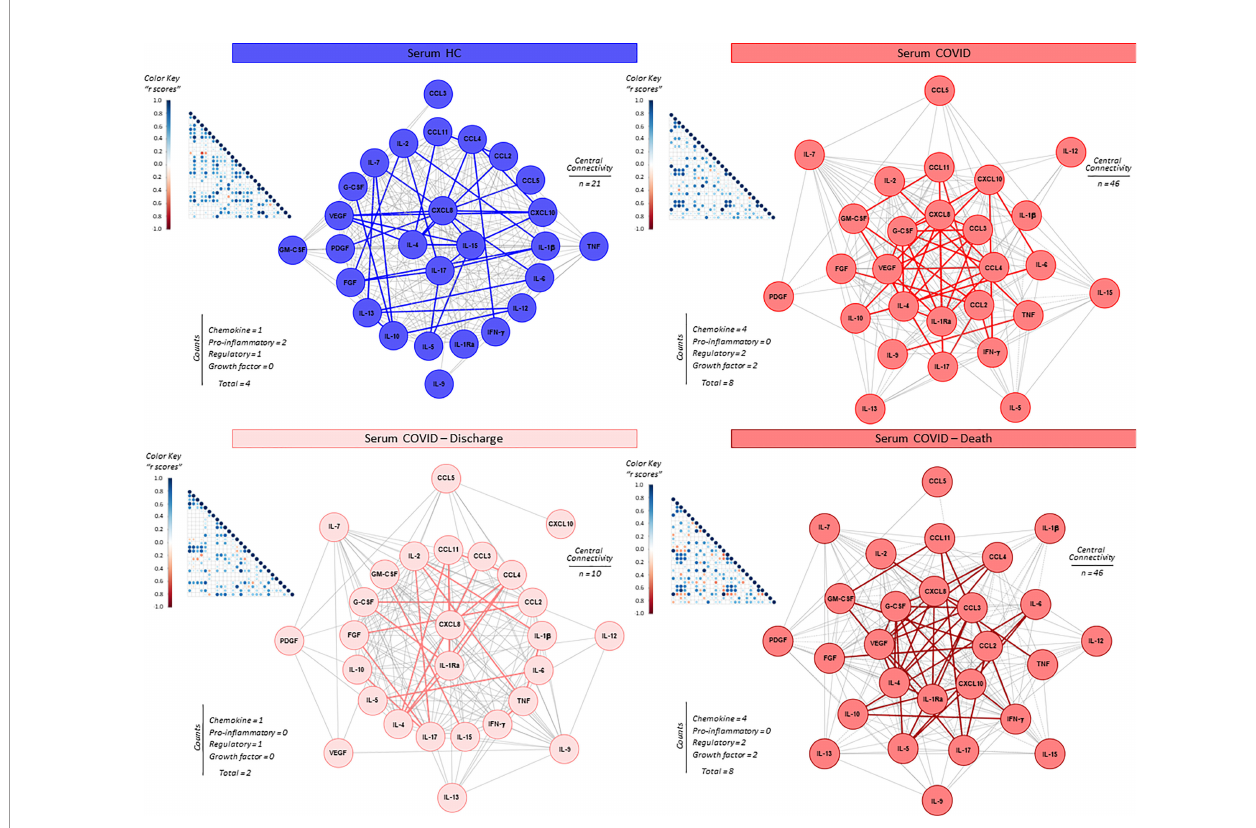
FIGURE 3 | Integrative correlation matrices and networks analysis of serum soluble immune mediators in critically ill COVID-19 patients at ICU admission. Comprehensive correlation matrices were assembled based on the Pearson and Spearman “ r ” scores between chemokines, pro-in fl ammatory cytokines, regulatory cytokines and growth factors measured in serum samples from critically ill COVID-19 patients – “ COVID ” ( ● , n = 183) at ICU admission (D0=baseline), further classi fi ed according to disease outcome: referred as “ Discharge ” ( ● , n = 97) or “ Death ” ( ● , n = 86) and pre-pandemic healthy controls – “ HC ” ( ● , n = 135). The soluble mediators were measured by high-throughput microbeads array as described in Material and Methods section. Panoramic correlation matrices are shown as triangle templates with each square intersection representing the “ r ” correlation score between pairs of attributes. The “ r ” scores of signi fi cant correlations (p < 0.05) are represented by circles of proportional sizes, scaled from − 1 to +1 with gradient for negative (red dots) and positive (bule dots) according to the color key provided in the fi gure. The white squares represent non-signi fi cant correlations. Networks were built using a layout based on eccentricity, considering all signi fi cant correlations. The nodes represent the chemokines (CXCL8, CCL11, CCL3, CCL4, CCL2, CXCL10), pro-in fl ammatory cytokines (IL-1 b , IL-6, TNF, IL-12, IFN- g , IL-15, IL-17), regulatory cytokines (IL-1Ra, IL-4, IL-5, IL-9, IL-10, IL-13) and growth factors (FGF-basic, PDGF, VEGF, G-CSF, GM-CSF, IL-7 and IL-2). Connecting edges illustrate weak/moderate ( “ r ” scores between |0.1 to 0.67|, thin gray lines) and strong correlation ( “ r ” scores ≥ |0.67|, thick colored lines) between pairs of attributes. Negative correlations are underscored by dashed lines. Attributes without strong correlations are distributed in the network periphery. Serum soluble mediators presenting at least 5 strong correlations are assembled in the center with the number of each category and connections between them (central connectivity) are provided in the